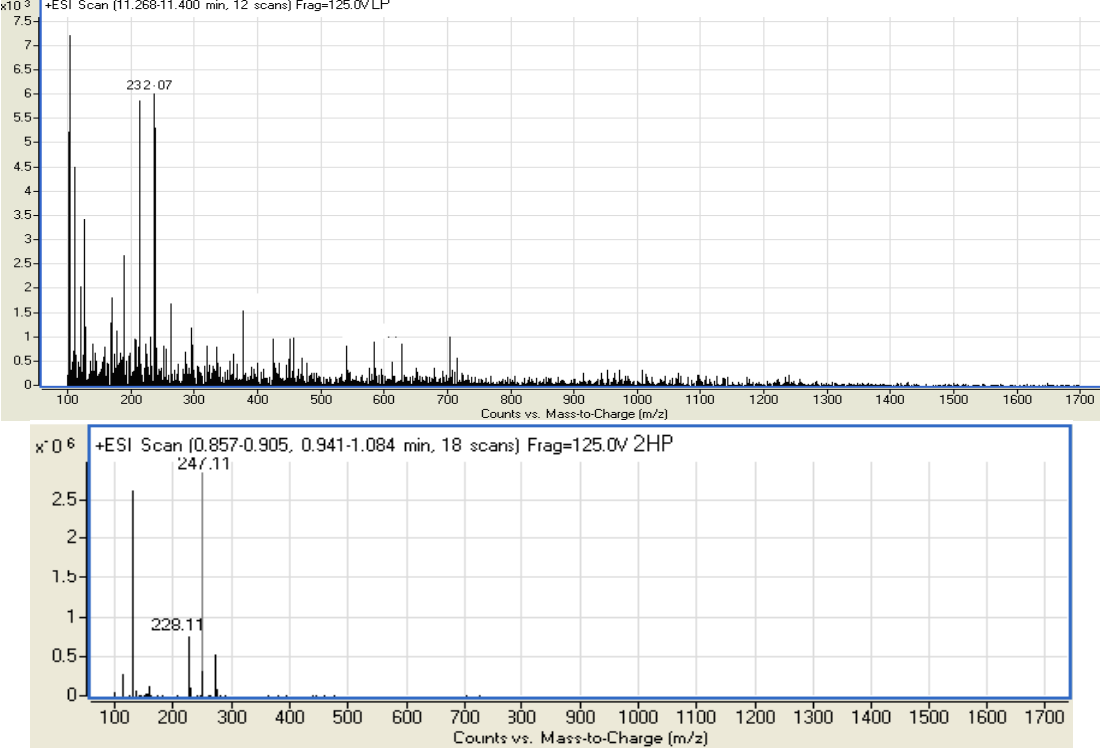
Figure 2. Mass spectra for the compounds LP , 2HP and DHP